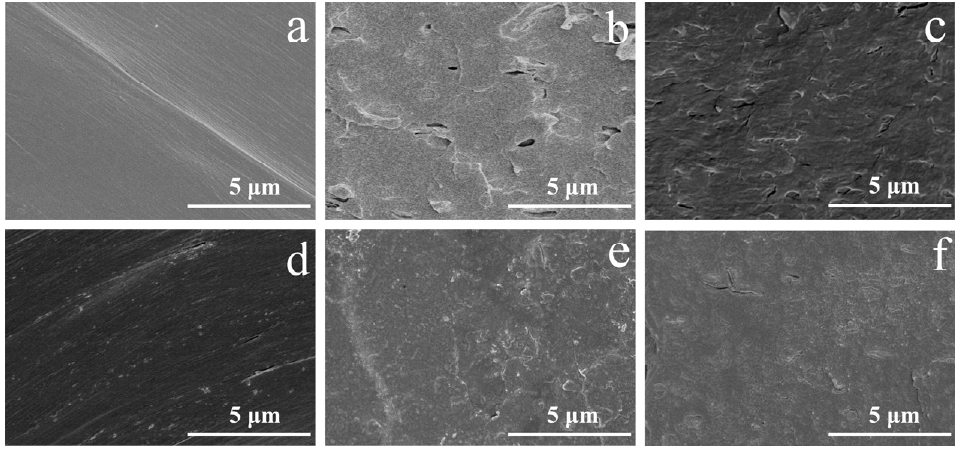
Figure 2. The SEM photographs of the impact fracture surface for the HIPS compounds: ( a ) HIPS; ( b ) HIPS/IFR; ( c ) HIPS-1; ( d ) HIPS-2; ( e ) HIPS-3; ( f ) HIPS-4.